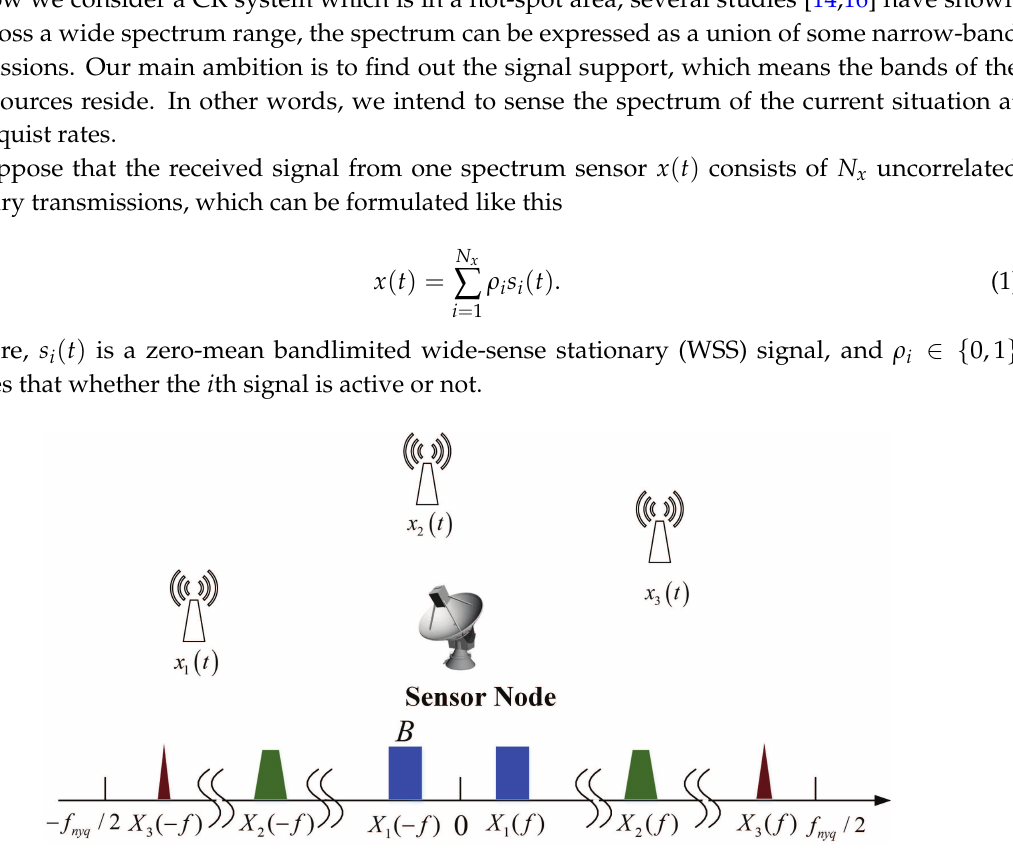
Figure 1. Typical spectrum support of a multiband signal composed of three RF